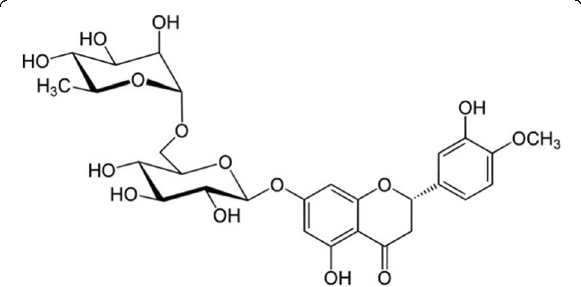
Fig. 1 The chemical structure of hesperidin ((2 S )-5-hydroxy-2-(3- hydroxy-4-methoxyphenyl)-7-[(2 S ,3 R ,4 S ,5 S ,6 R )-3,4,5-trihydroxy-6- [[(2 R ,3 R ,4 R ,5 R ,6 S )-3,4,5-trihydroxy-6-methyloxan-2-yl]oxymethyl]oxan-